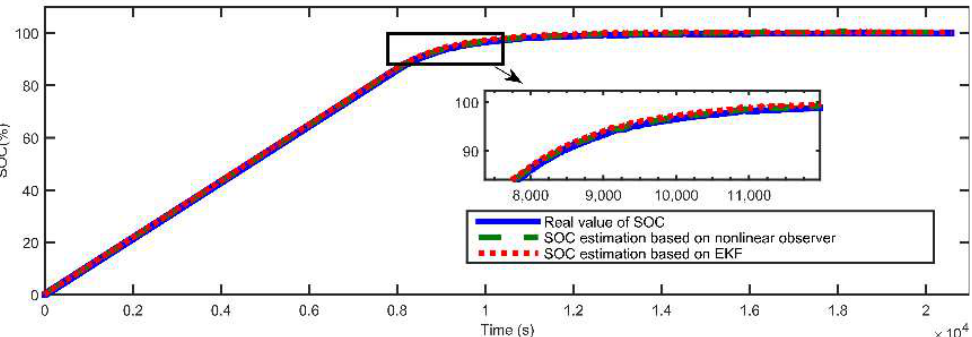
Figure 25. Comparison of SOC estimation based on non-linear observer and EKF in dynamic condition test 3.